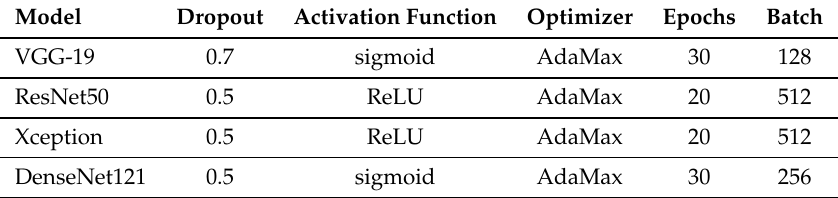
Table 1. Hyperparameters and training setings for the CNN